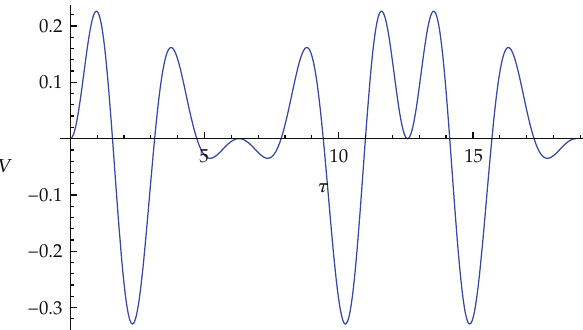
Figure 30: The evolution of the volume of the M¨obius strip universe for (cid:2) 5.16 (cid:3) with (cid:2) 3.4 (cid:3) and α (cid:6) Λ (cid:6) 1.